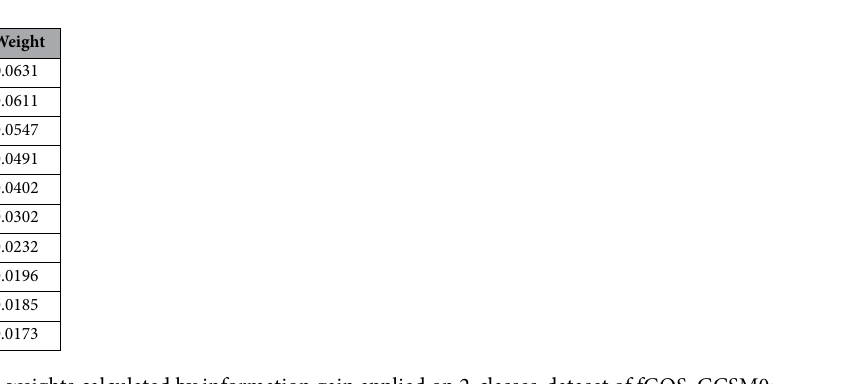
Table 11. Feature weights calculated by information gain applied on 2-classes-dataset of fGOS. GCSM0: motor component of GCS on admission, INR: international normalized ratio, DC: decompressive craniotomy, SAH: subarachnoid hemorrhage, BS: blood sugar, IVH: intraventricular